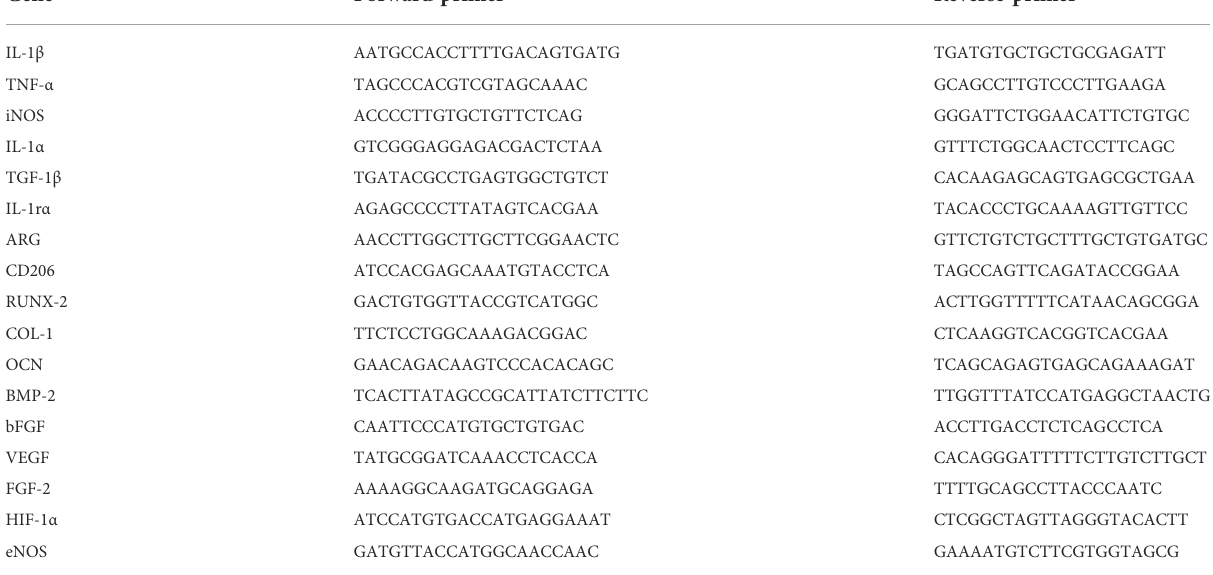
TABLE 1 Primers for gene expression